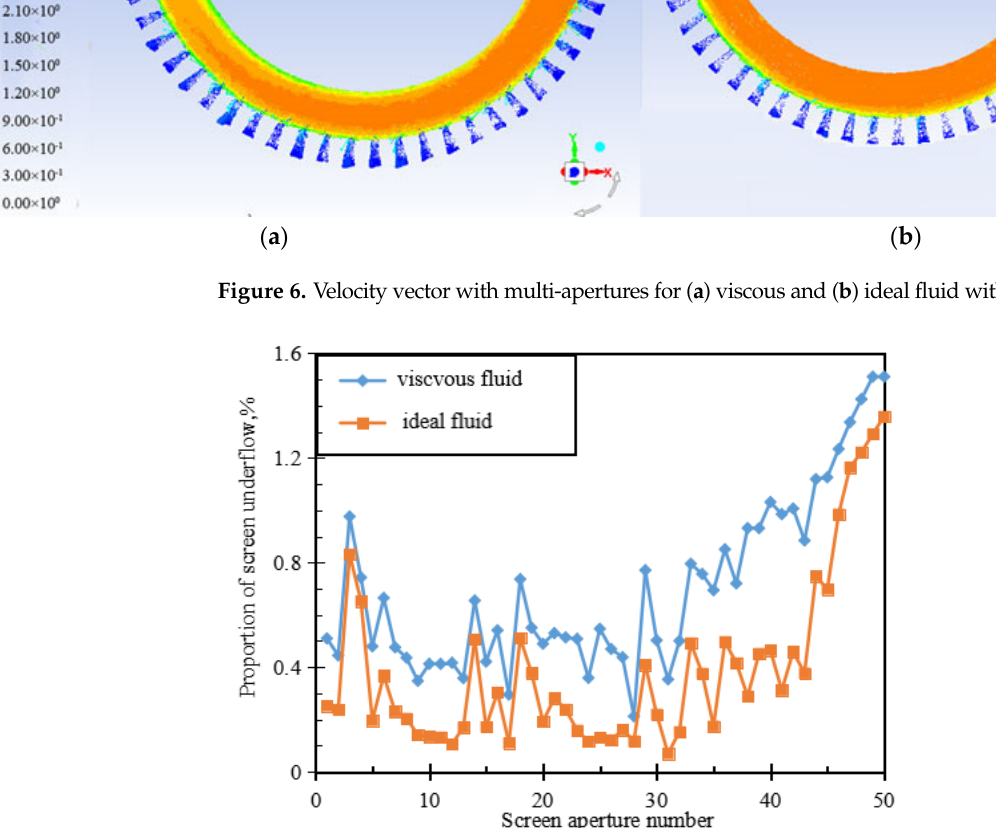
Figure 7. Distribution of the proportion of screen underflow under multi-aperture conditions.